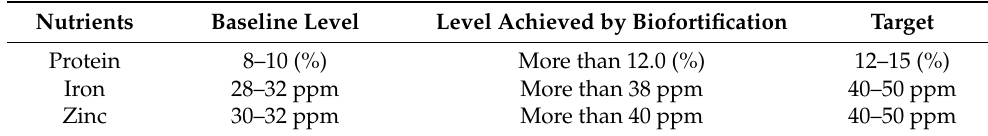
Table 1. Baseline level achieved by biofortification in wheat (Indian